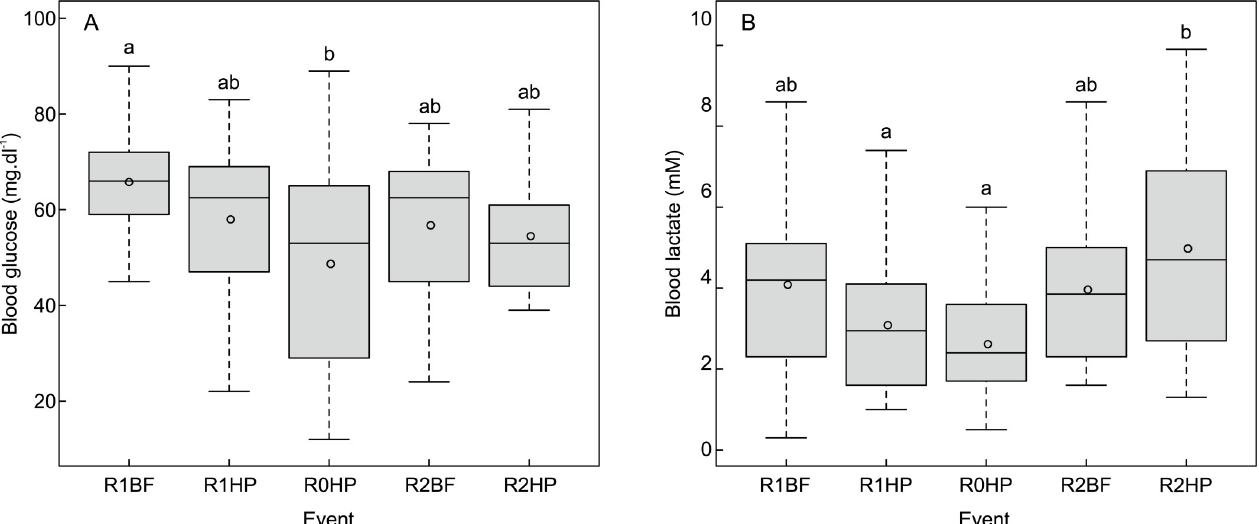
Fig 4. Boxplots of the variation of (A) blood glucose (mg.dl -1 ) and (B) lactate (mM) levels for L . bocagei . R1BF and R2BF–Base-flow event in the presence of solid triangular pyramids and v-shaped structures respectively; R0HP, R1HP and R2HP–Hydropeaking event in the absence of structures, presence of solid triangular pyramids and the presence of v-shaped structures, respectively. The letters correspond to the post-hoc test results. The circles correspond to the mean value of the physiological response for each treatment.